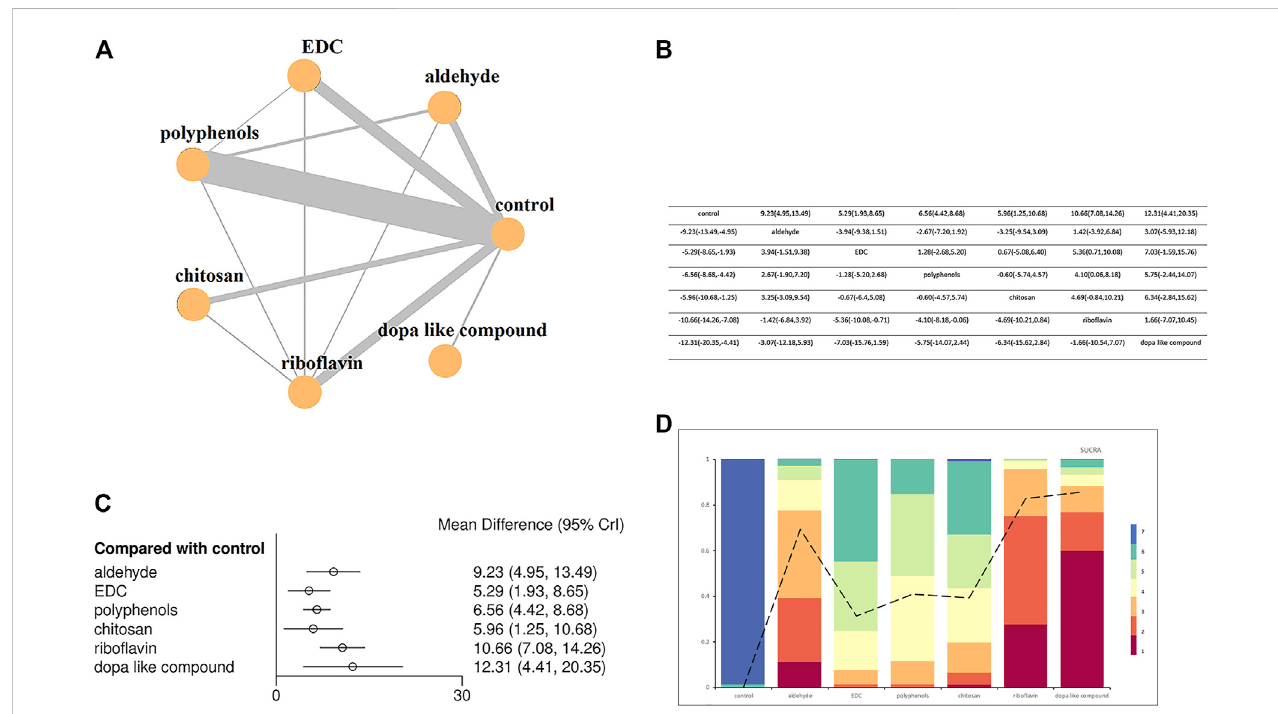
FIGURE 6 Networkmeta-analysiscomparingthelong-term bondstrengthbetweenthecontrolgroupandthesixtypescross-linkers. (A) Networkplotwhereeach nodeindicatesadirectcomparison(control,aldehyde,EDC,polyphenols,chitosan,ribo fl avinanddopalikecompound)withthethicknessofconnectinglines between nodes representing the number of studies compared. (B) League table showing Bayesian comparisons for all groups: this table shows the results for all group pairs in the upper (direct comparison) and lower (indirect comparison) triangles, but the comparisons have been switched; For the leading diagonalaboveandbelow,theresultisthegroupingatthetopofthesamecolumnversusthegroupingtotheleftofthesamerow. (C) Bayesianrandomeffect consistencymodelforestplotofthepooledeffectsestimatesofbondstrengthsexpressedinmeandifference(MD)andrespective95%credibleintervals(95% CrI) for different adhesive groups compared with the control group. (D) Cumulative ranks and